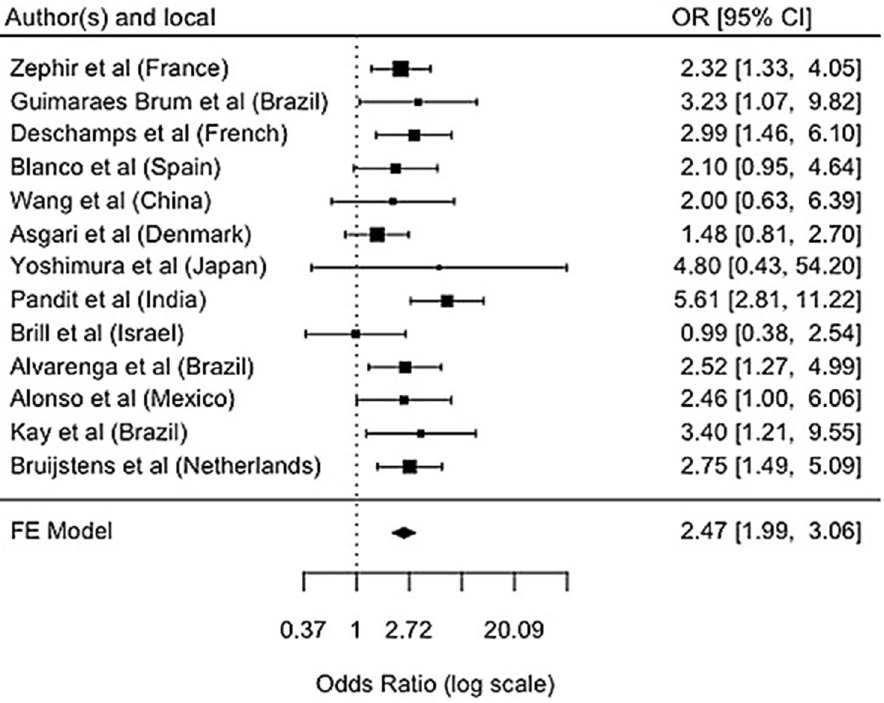
Figure 2. Meta-analysis: association of DRB1 *03 allelic group with NMO. Comparison of DRB1 *03 allele group association using meta-analysis based on the OR and the confidence interval (95% CI) described in the thirteen studies. The forest plot shows the summary measure of OR equal to 2.46 (95% CI 2.01–3.01). That is, patients with neuromyelitis optica are 2.46 times more likely to have the DRB1 *03 allele group than controls. In the West, studies are not heterogeneous (I 2 = 0.00%; p = 0.92), with the measure of OR equal to 2.38 (95% CI 1.90–2.97), but in Asia the result of the meta-analysis showed a heterogeneity of 67% (I 2 = 66.91%; p = 0.02).